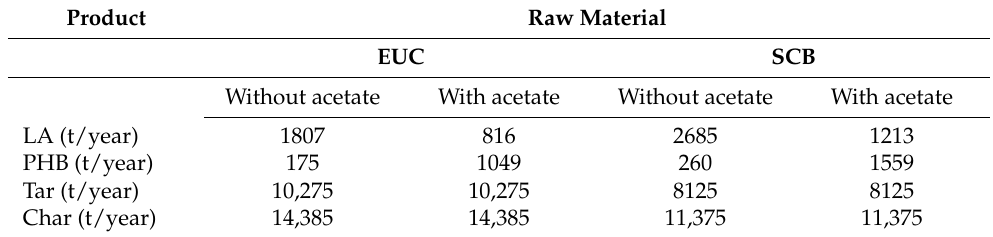
Table 4. Total products obtained by each evaluated scenario.